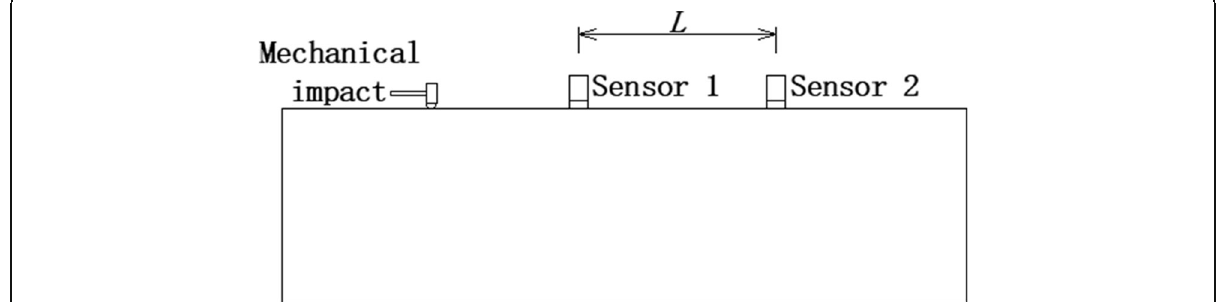
Fig. 3 Schematic of testing configuration for determining the velocity of